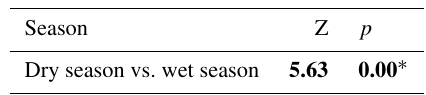
Table 4. Mann–Whitney U test for ecohydrological sensitivity be- tween dry season and wet